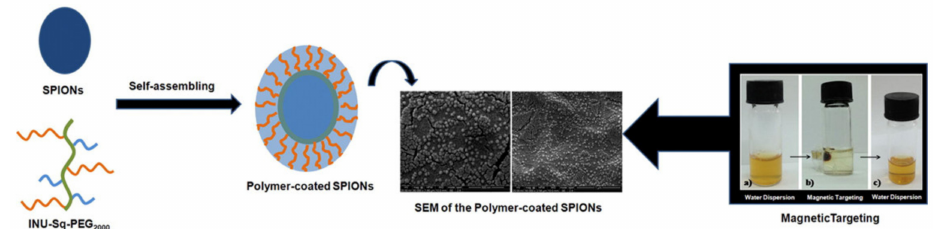
Figure 11. Inulin-based polymer coated SPIONs loaded with DOX. Reproduced with permission from [207] Copyright 2014,